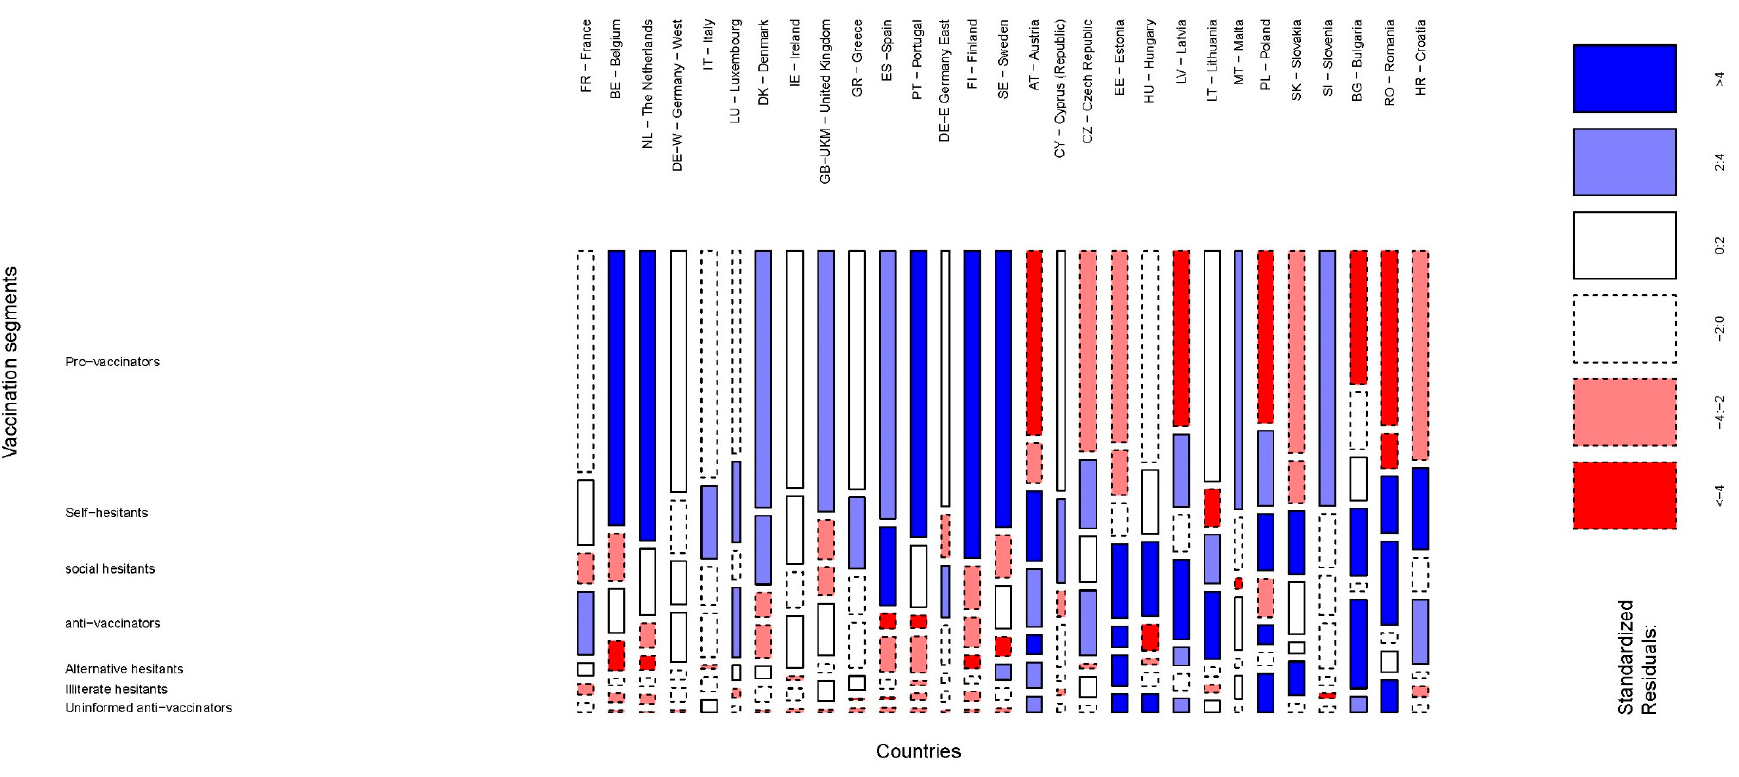
Figure 2. European Attitudes Towards Vaccination. Segments by Country.